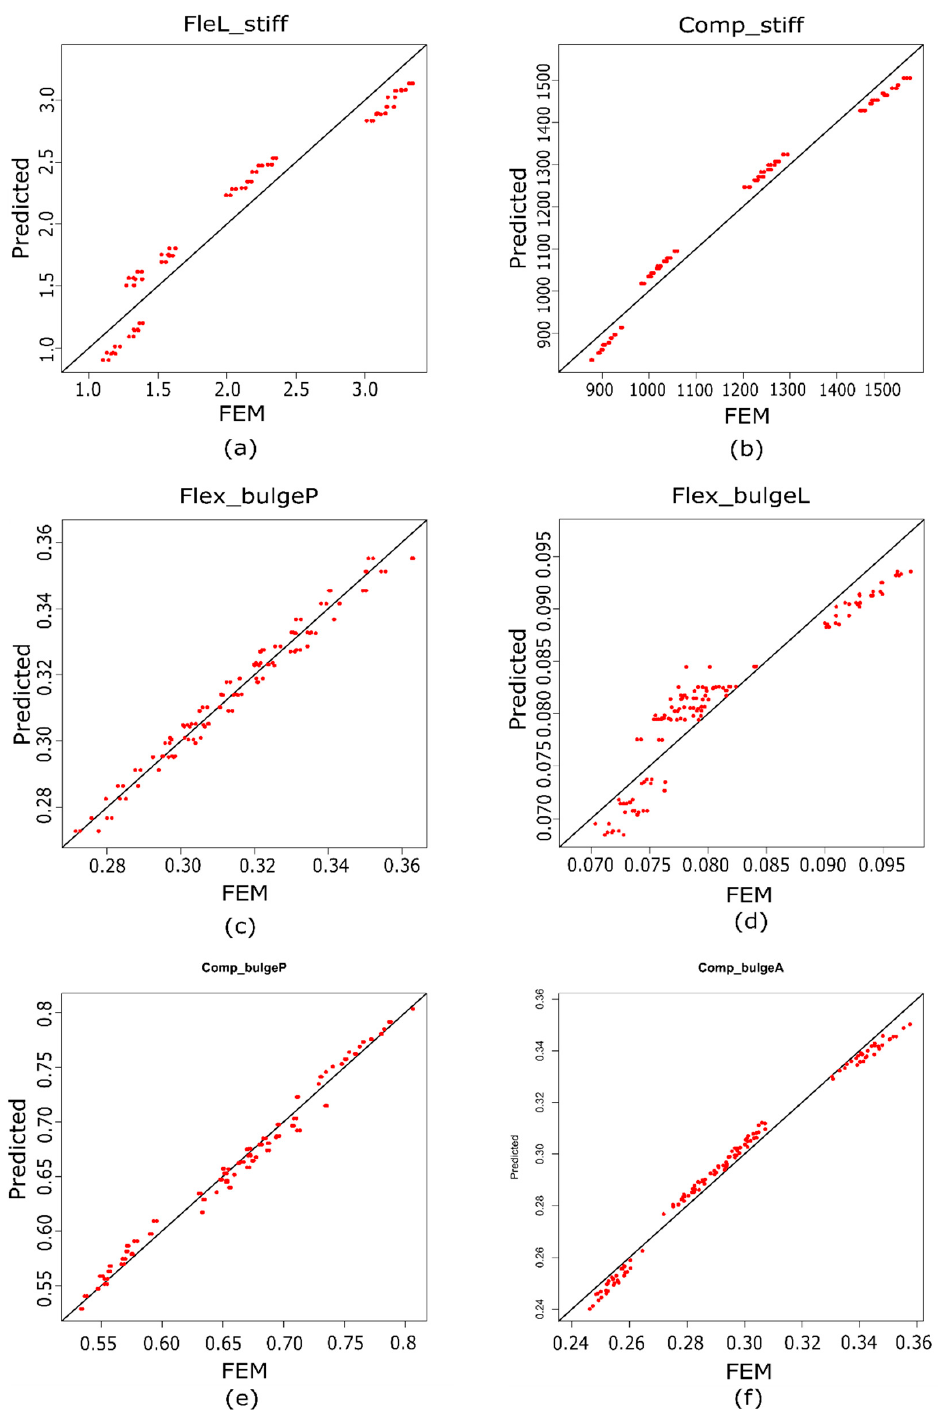
Figure 7. Scatter diagram of ( a ) lateral bending stiffness; ( b ) compression stiffness; ( c ) flexion bulge posterior; ( d ) flexion bulge lateral; ( e ) compression bulge posterior; and ( f ) compression bulge anterior.